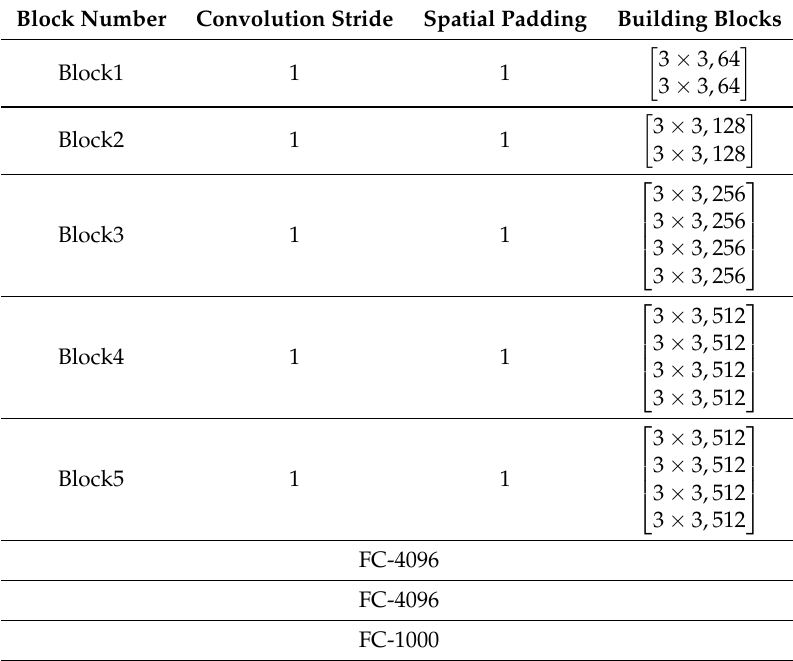
Table 1. The architecture of VGG-19. The left part in “Building Blocks” indicates the size of receptive fields, and the right part indicates the number of filter